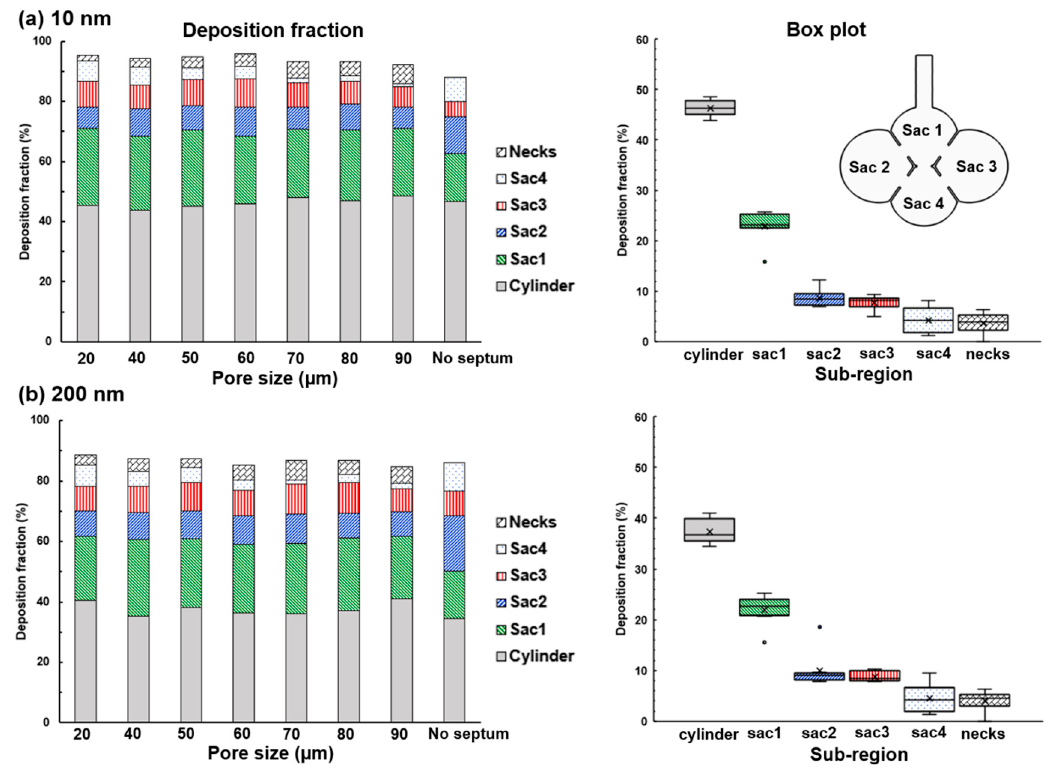
Figure 12. of particle deposition in the alveolar models with different pore sizes: ( a ) 10 nm, and ( b ) 200 nm. Box plots of the sub-regional deposition fractions were shown in the right panels for 10 nm and 200 nm, respectively.